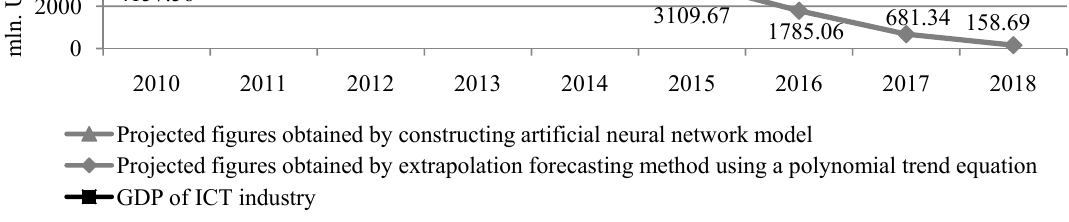
Fig. 6. Predictive value of IT market volume in 2016-2018